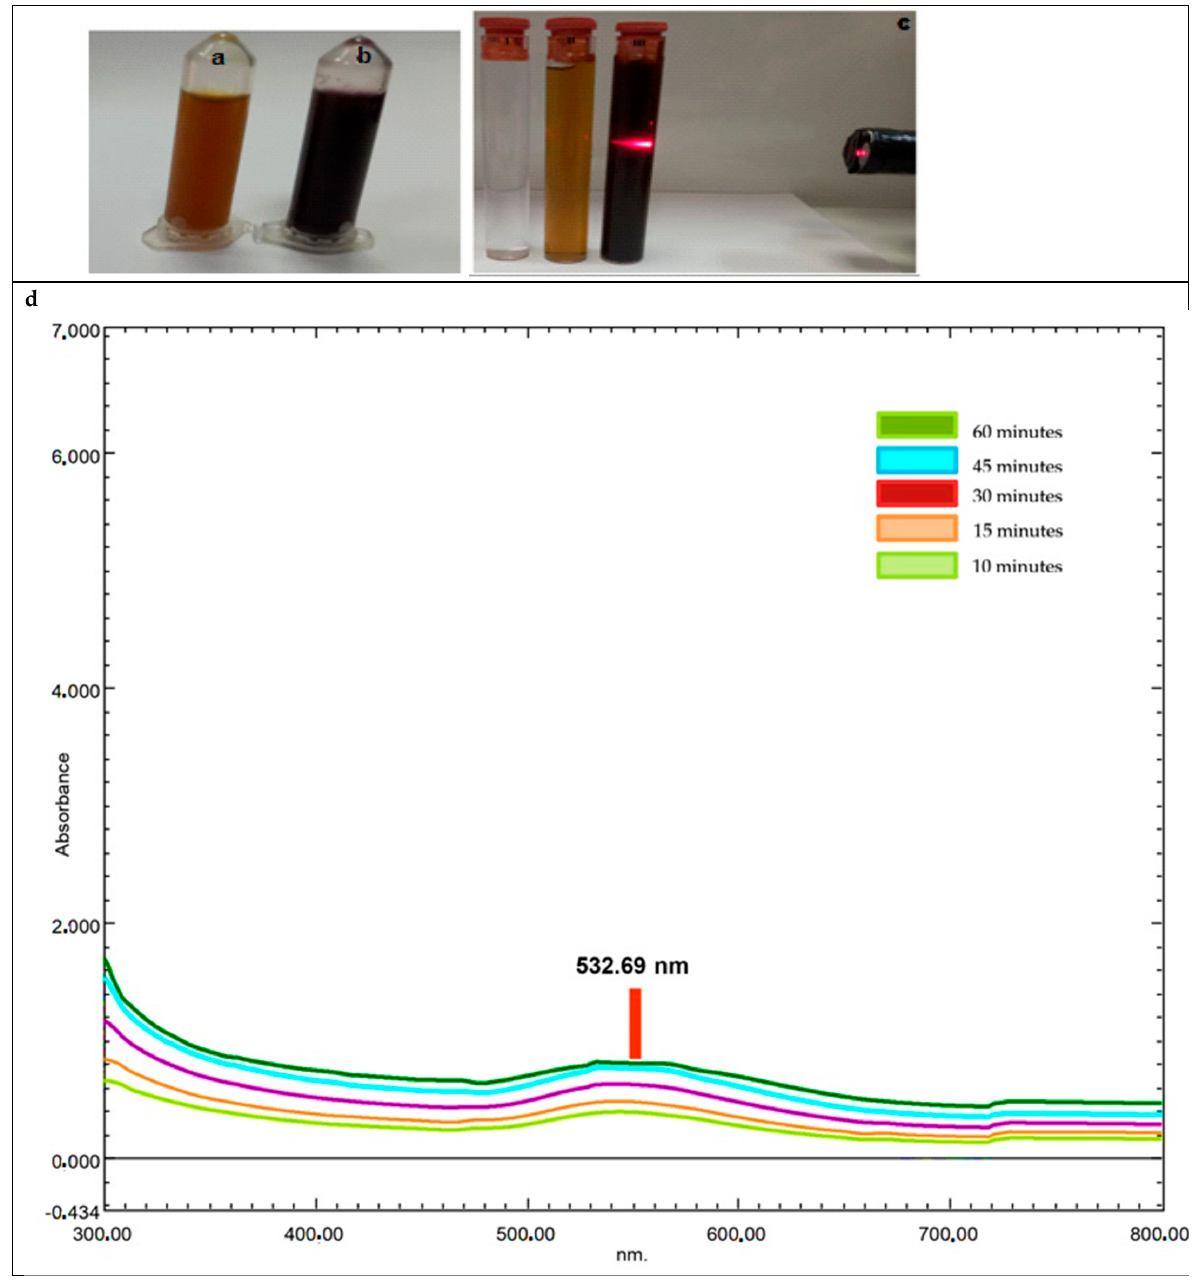
Figure 2. ( a ) Amygdalus communis leaf extract. ( b ) Color change due to the formation of synthesized AC-AuNPs. ( c ) The presence of AuNPs in colloidal form confirmed by the Tyndall effect against the laser beam (I. HAuCl 4 solution, II. plant extract, and III. colored liquid formed as a result of synthe- sis). ( d ) Time-dependent maximum absorbances (10 to 60 min).